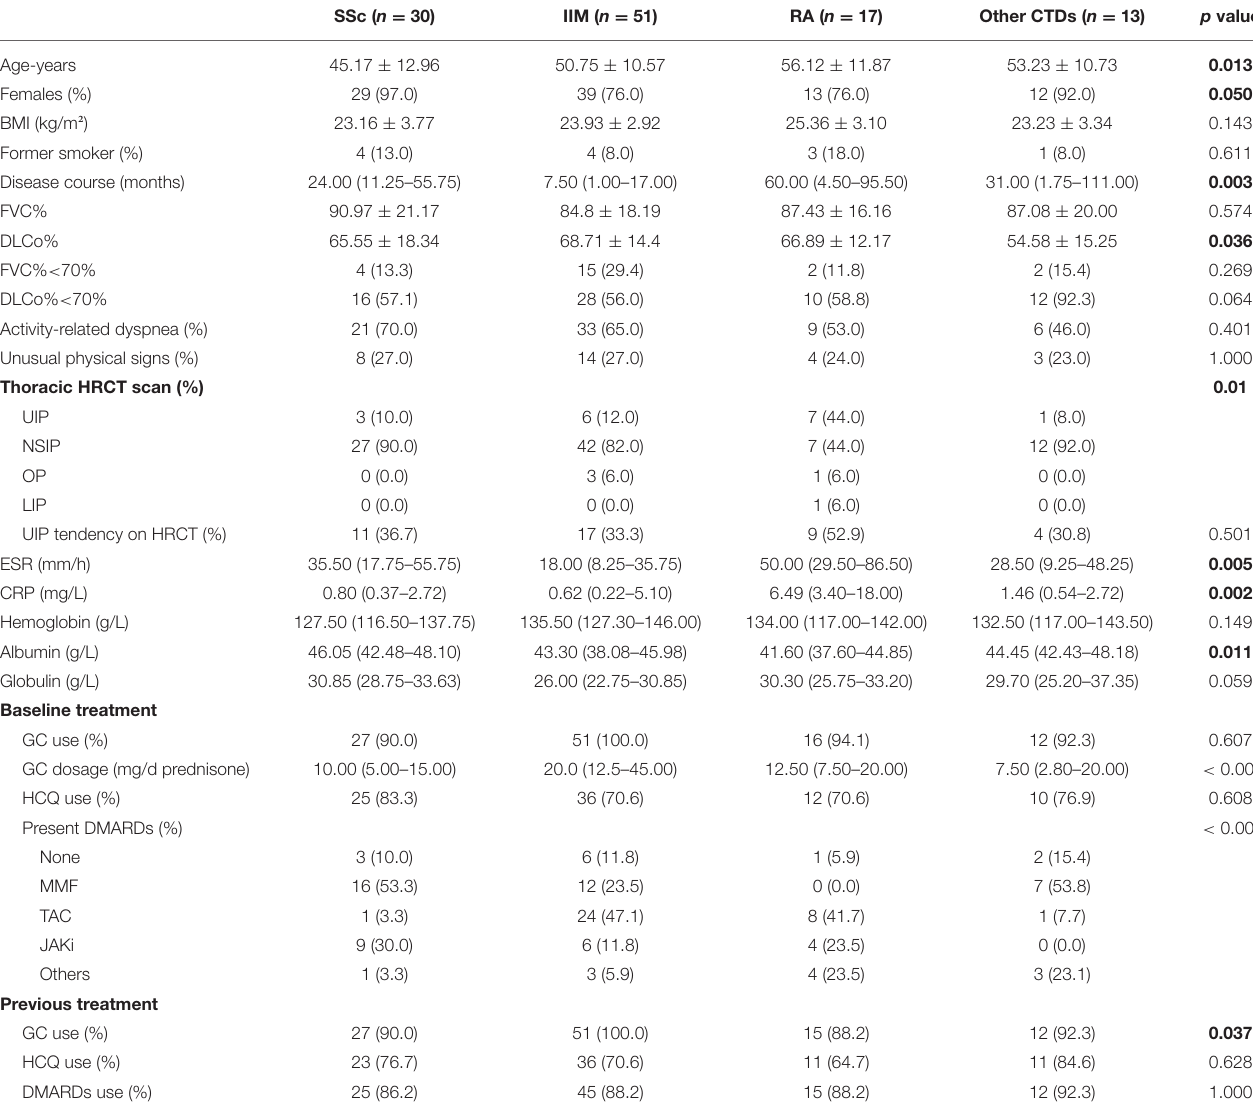
TABLE 1 | The baseline clinical characteristics, PF, HRCT imaging features, and therapeutic regimen of the 4 CTD-ILD groups. SSc ( n =